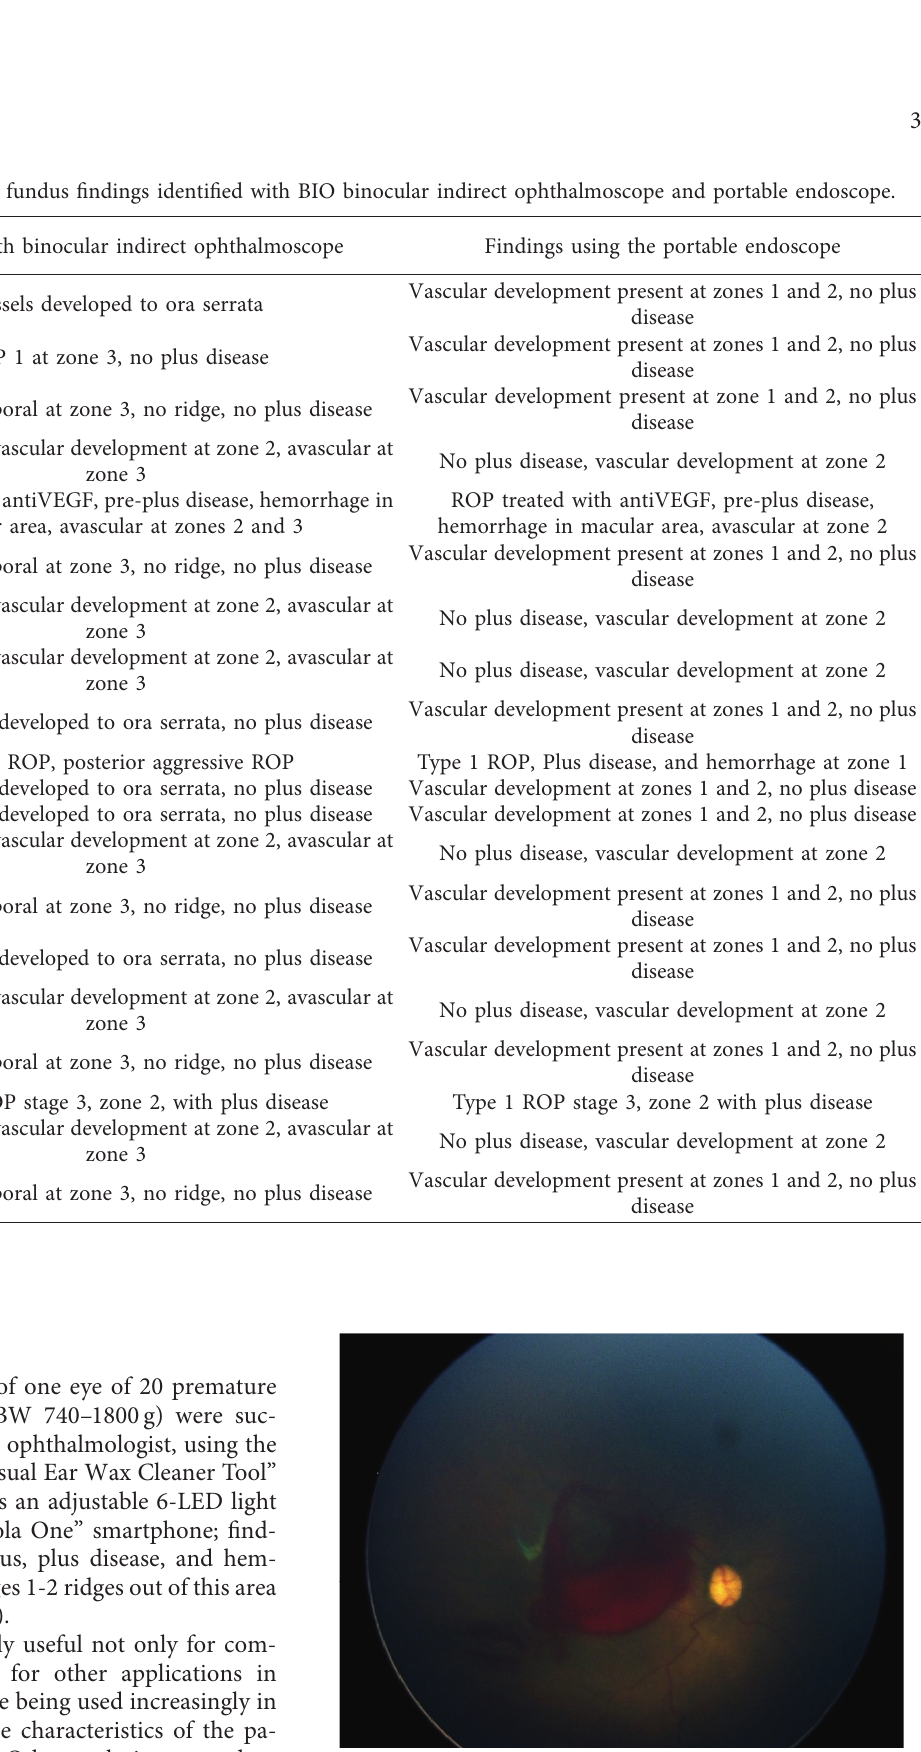
Figure 2: RetCam right eye fundus photograph of a premature patient with 33.5 weeks of postmenstrual gestational age with ROP treated with antiVEGF, which developed a macular